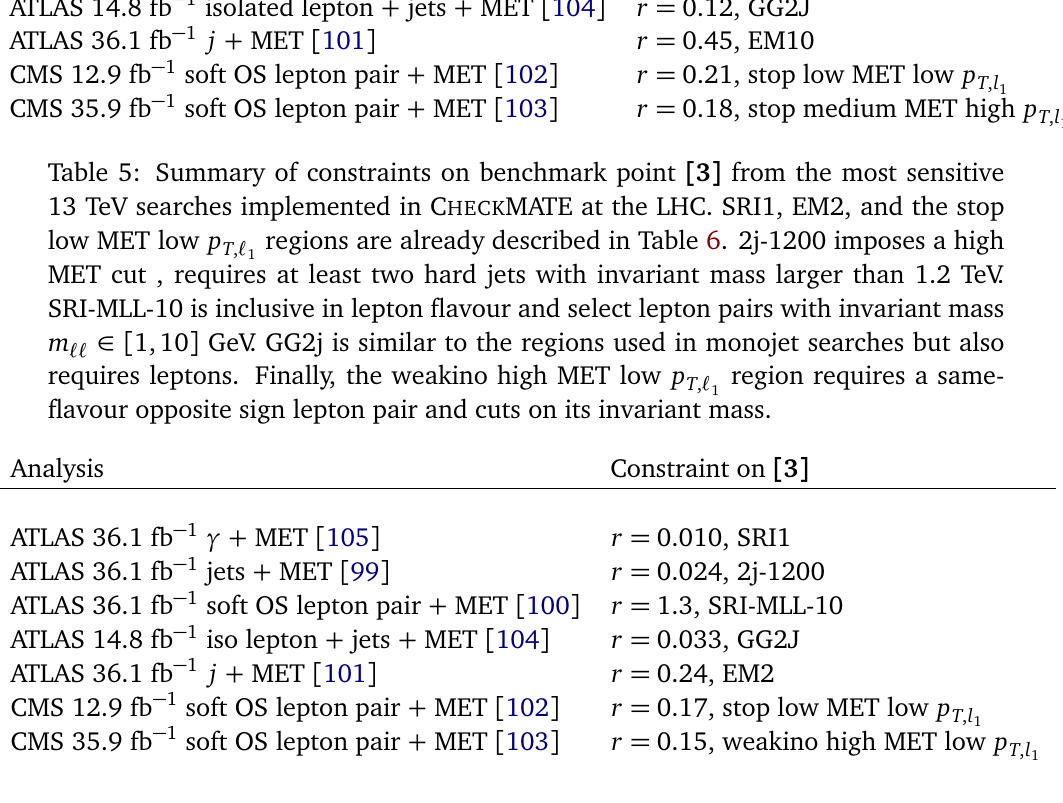
Table 4: Summary of constraints on benchmark point [ 2 ] from the most sensitive 13 TeV searches implemented in C HECK MATE at the LHC. The EM2 region is the − body -SF is originally designed for stops with same as the one shown in Table 6. SR 3 W ∆ m ( χ ) ∼ m and hence imposes a b -quark veto and cuts on a “super-Razor” (cid:101) t , W variable M R , that reaches an endpoint near the stop-neutralino mass splitting. 3LI ∆ simply imposes a moderate missing E cut and a tight requirement on the p of the T T third lepton. Finally, SR A25 imposes a harder / E cut as well as a transverse mass T cut, and tags Z bosons.